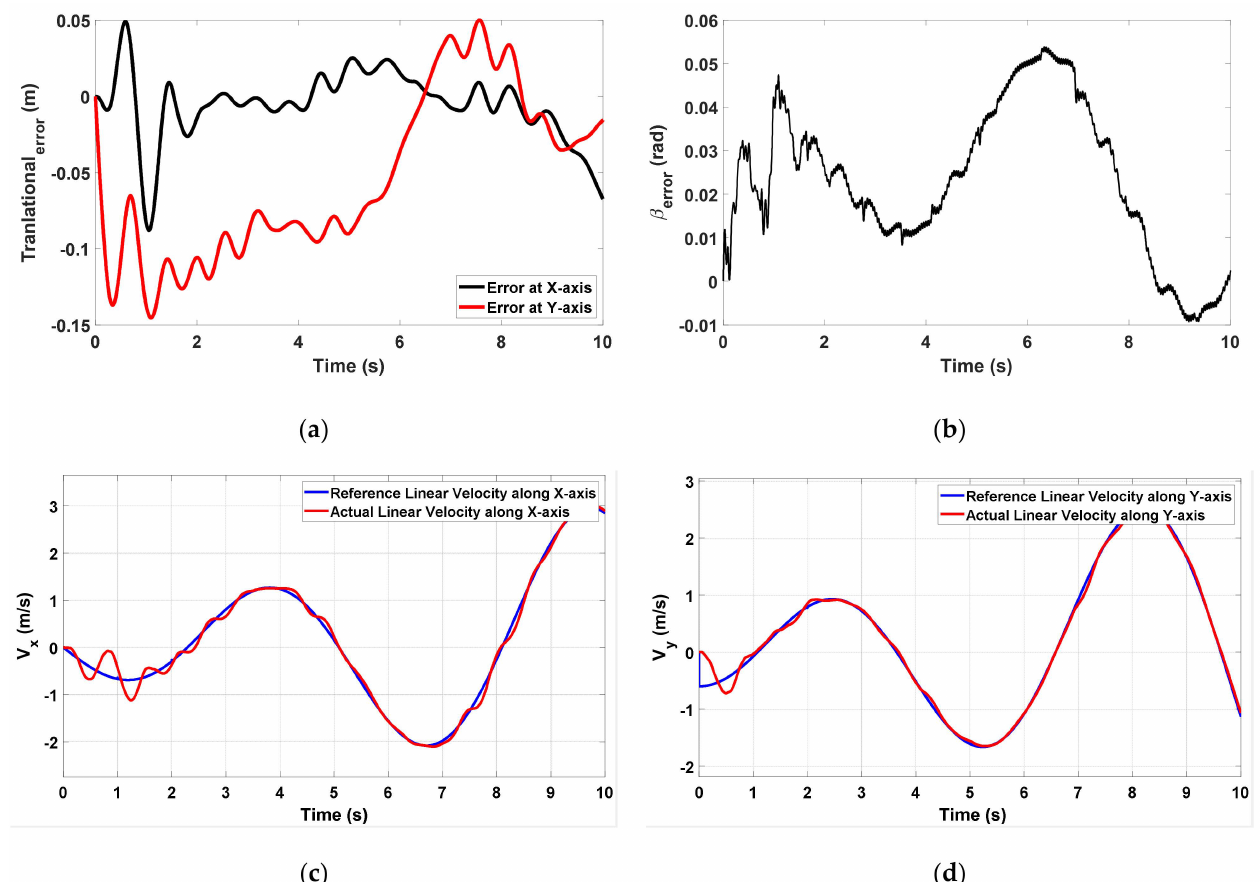
Figure 9. ( a ) The translational motion errors of the AGV at X and Y axis during the spiral path. ( b ) The rotational motion error of the AGV. ( c ) The reference and actual linear velocity of the AGV along X axis. ( d ) The reference and actual linear velocity of the AGV along Y